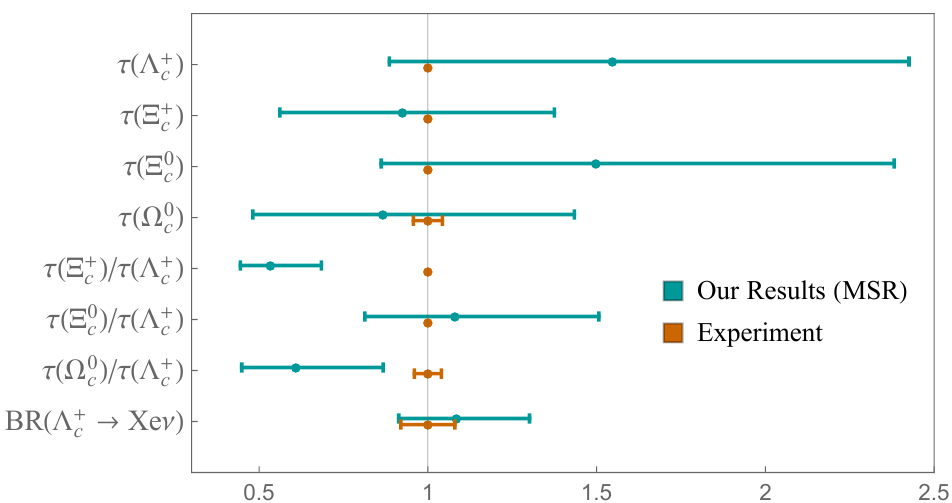
Figure 5. Predictions for observables in the singly-charmed baryon sector, normalized to the corresponding experimental values, in the MSR scheme. Experimental values (lower of each pair) are in orange, with uncertainties provided when they are larger than ∼ 1% . Our predictions are in bluegreen, with the uncertainties, from table 14, added linearly. Tensions in the ratios τ (Ξ + (cid:1) and τ (cid:0) Ω 0 ) are clearly visible, whereas predictions for the remaining observables are com- /τ (Λ + c c patible with experimental values within uncertainties. A similar figure for meson observables is provided in figure 7 of